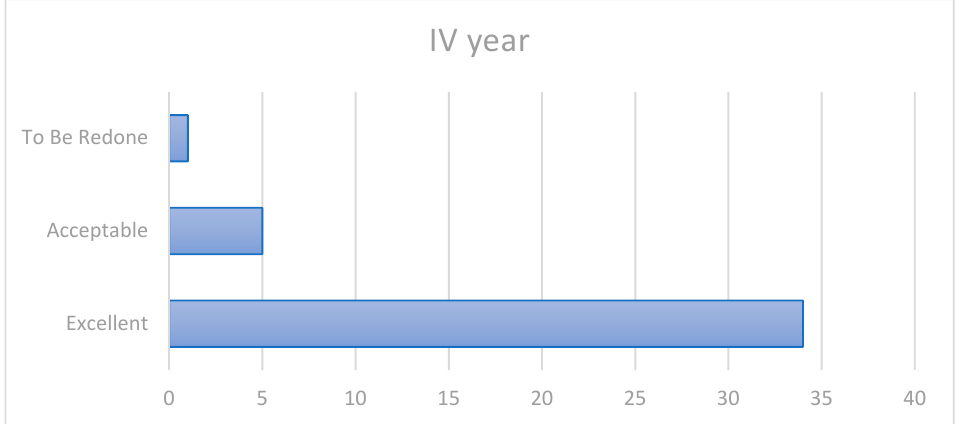
Figure 3. Fourth-year outcomes.